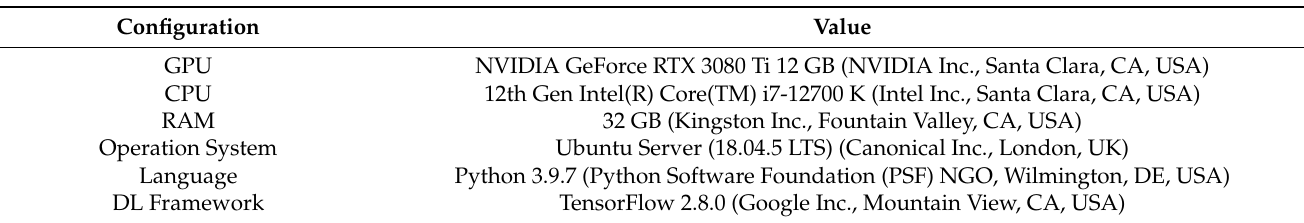
Table 4. Hardware and software environment.